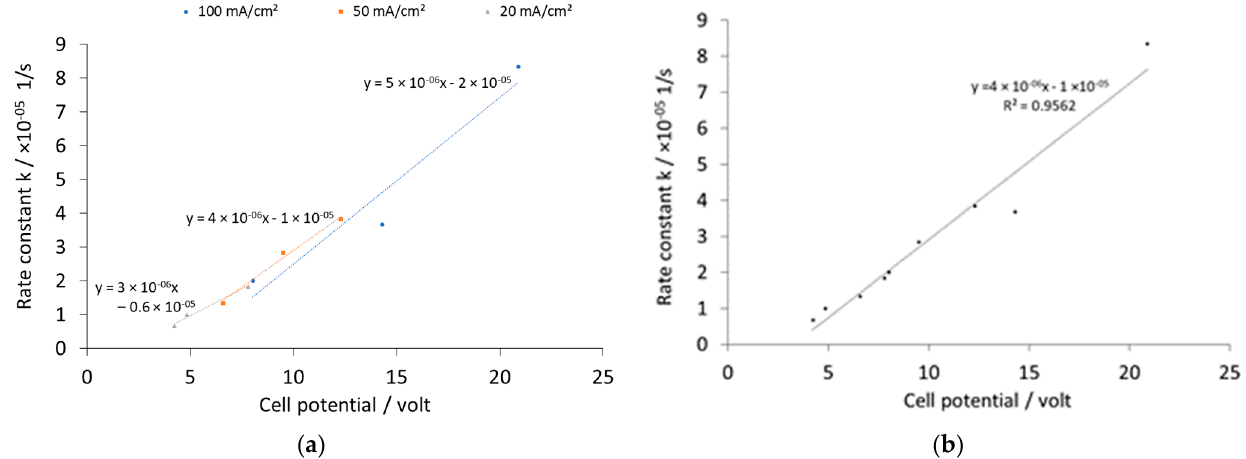
Figure 6. Three mathematical models ( a ) and its uniform model ( b ) to calculate the rate constant of